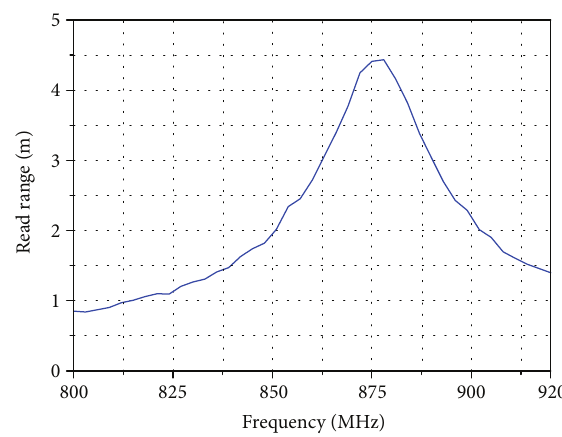
Figure 15: Voyantic read range